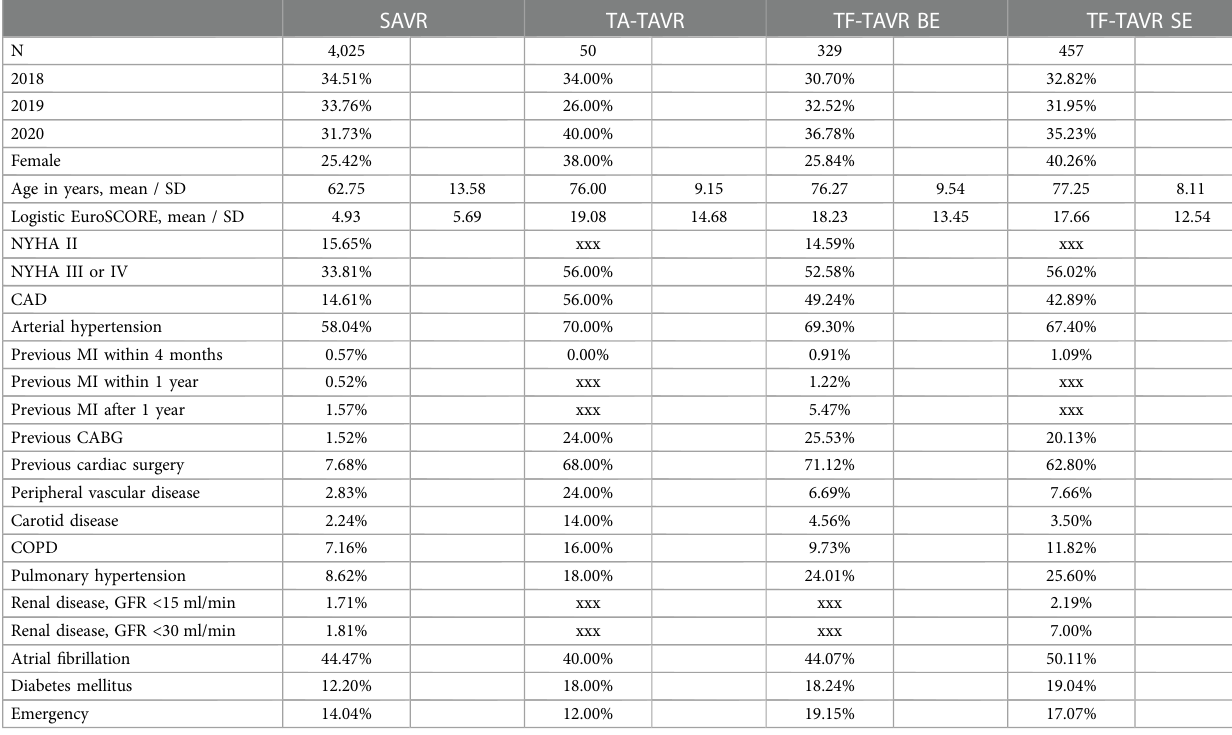
TABLE 1 Baseline characteristics of patients with pure aortic regurgitation between 2018 and 2020 in Germany.